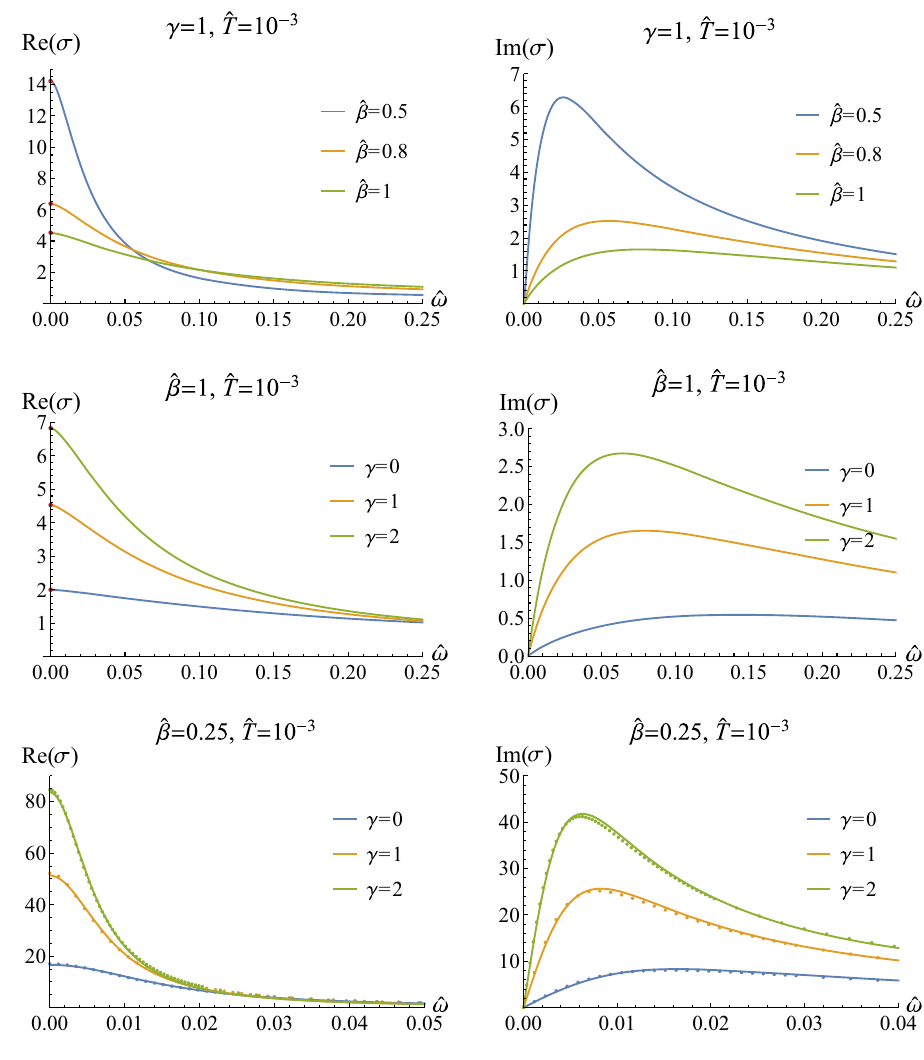
Table 1 The momentum relaxation rate (cid:18) fitted by the standard Drude formula (38) for different γ with fixed ˆ β = 0 .